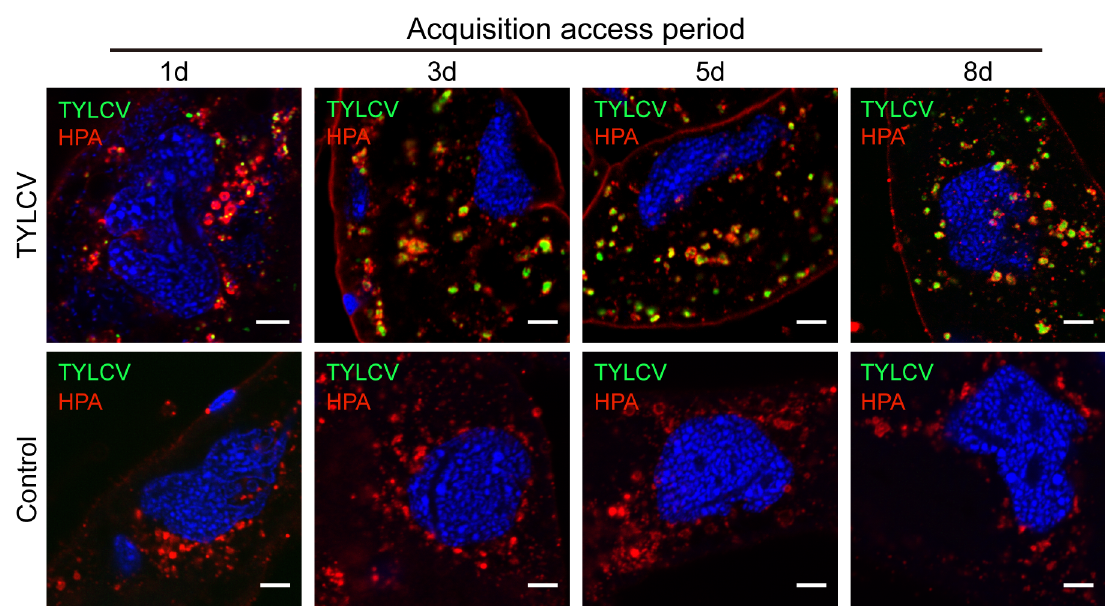
Fig 4. Time scale localization of TYLCV in the epithelial cells of whitefly midgut. Whiteflies were allowed to feed on TYLCV-infected plants for different AAP and prepared for immunofluorescence. Whiteflies that had fed on uninfected tomato plants were included as a negative control. At the four time points, colocalization between TYLCV and HPA was quantified as 0.24 ± 0.01, 0.44 ± 0.02, 0.44 ± 0.02 and 0.50 ± 0.05, respectively (Pearson’s coefficient, mean ± SE, n = 13–20). Scale bar, 5 μ m. Representative images that were used to generate the data are provided in S7